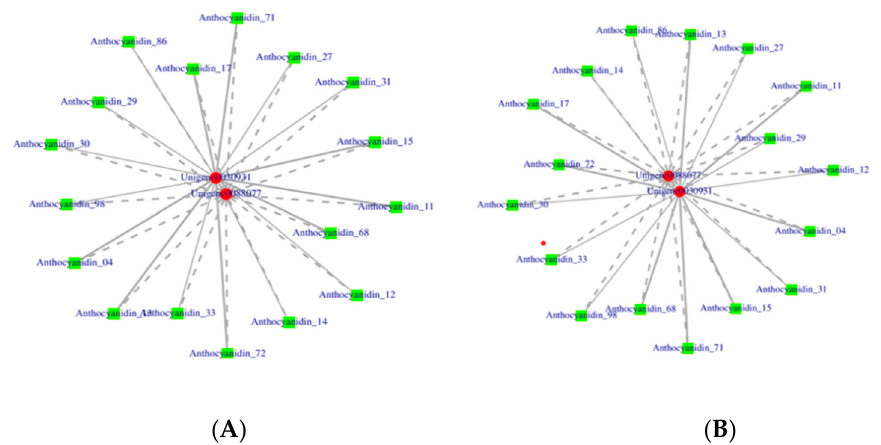
Figure 9. ( A ) UFGT gene and metabolite correlation network diagram of G vs. R. ( B ) UFGT gene and metabolite correlation network diagram of G vs. S. Solid lines indicate positive correlations whereas dashed lines indicate negative correlations. R, FZ-72 (red calyx); G, Baitao K (green calyx); S, MG5 (stripped calyx).